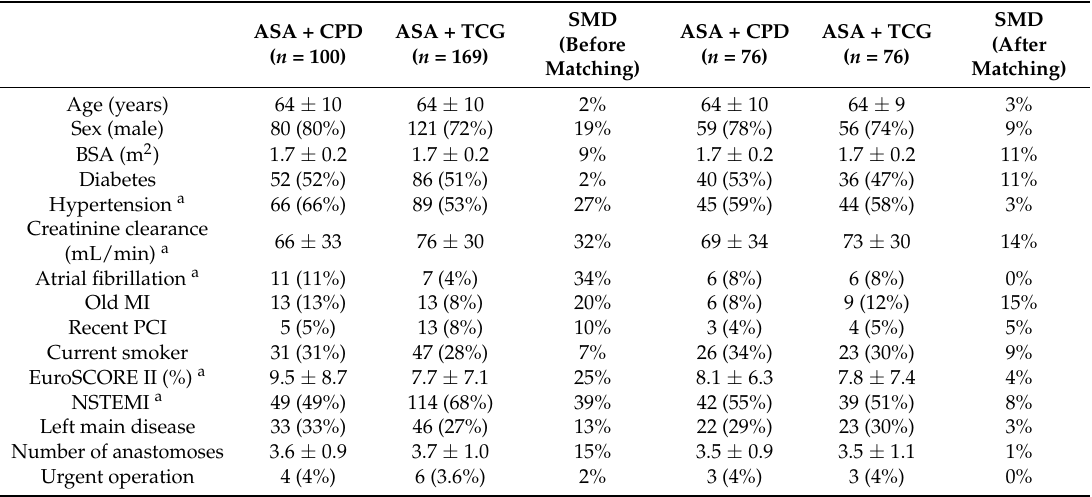
Table 5. Standardized mean difference (SMD) between the groups before and after propensity score